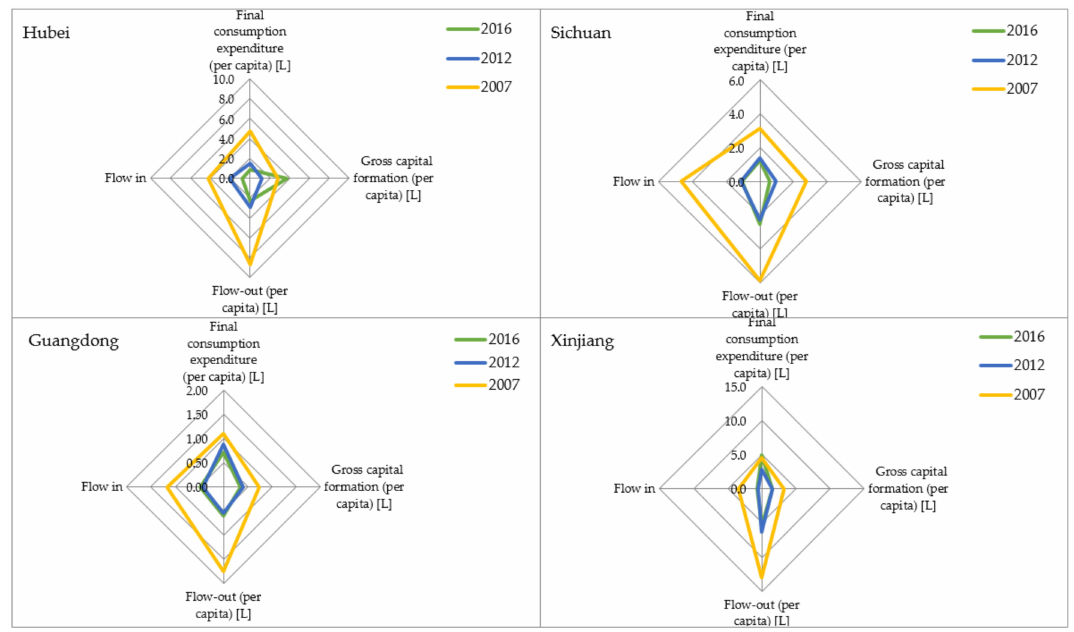
Figure A2. Changes of 4 indicators in 2007, 2012 and 2016 of Group 2.